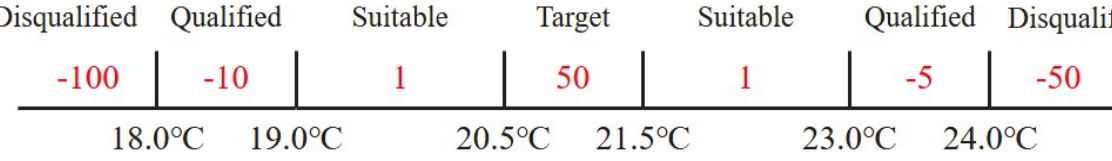
Figure 7. Design of reward function 3.